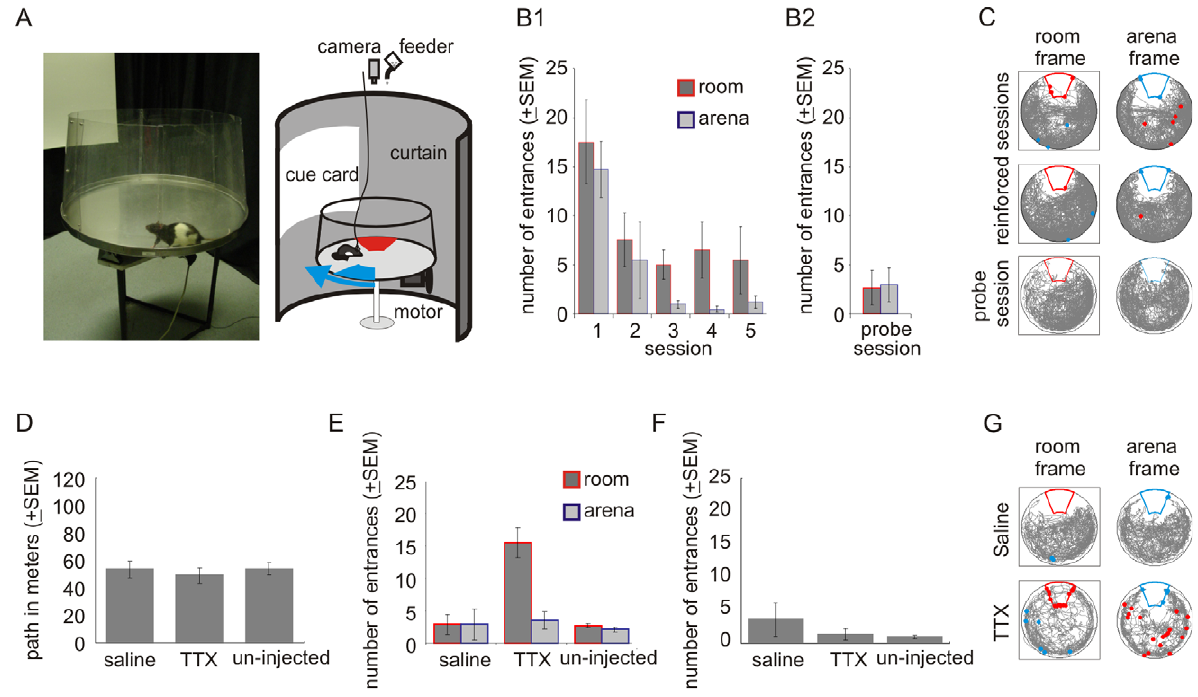
Figure 1. Hippocampus dependent two-frame avoidance. (A) Photograph (left) and schematic (right) of the active place avoidance apparatus. (B1) Learning two-frame avoidance. Entering the shock zones rapidly decreased with training ( n =4 rats; F 4,12 $ 7.96, p s , 0.01 for each spatial frame evaluated separately) and was asymptotic after 2 d (sessions 1 . 2=3=4=5, Newman-Keuls post hoc tests). (B2) Place avoidance was equally good on a no-shock probe session. (C) Example behavior. The rat’s path (grey) in the separate room and arena spatial frames and shocks in the room (red) and arena (blue) shock zones are marked by correspondingly colored dots. (D–F) Two-frame avoidance is hippocampus dependent. (D) Injecting TTX or saline into one hippocampus did not affect walking on the rotating arena (F 2,6 =0.37, p =0.71). (E) TTX but not saline selectively impaired two- frame avoidance of the room shock zone (F 2,6 =9.12, p , 0.05; Newman-Keuls post hoc tests p , 0.05*) but not the arena shock zone. (F) TTX did not impair avoidance on the stable arena (F 2,6 =1.16, p =0.38). (G) Example of behavior after unilateral saline or TTX